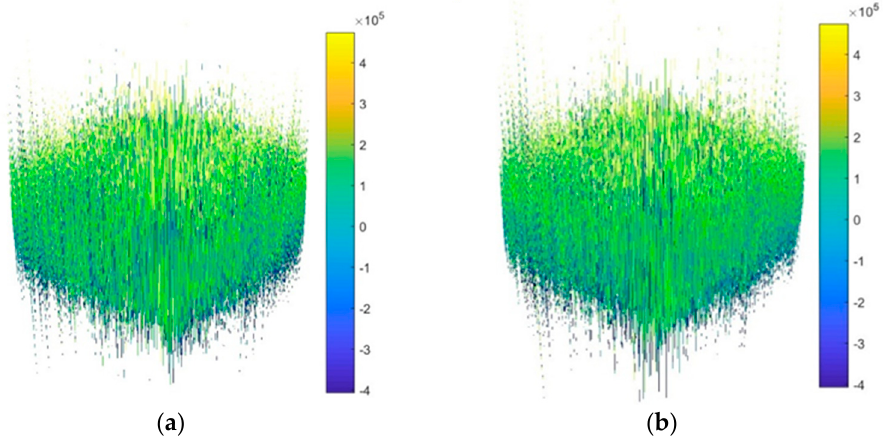
Figure 13. Three-dimensional images of decrypted DEM A: ( a ) with keys 𝑟 (cid:2868) = 3.7004182, 𝑥 (cid:2868) = 0.28, 𝑟 (cid:2868) = 3.8994119, and 𝑦 (cid:2868) = 0.86; ( b ) with keys 𝑟 (cid:2868) = 3.8777651, 𝑥 (cid:2868) = 0.21, 𝑟 (cid:2868) = 3.7276262, and 𝑦 (cid:2868) = 0.27.